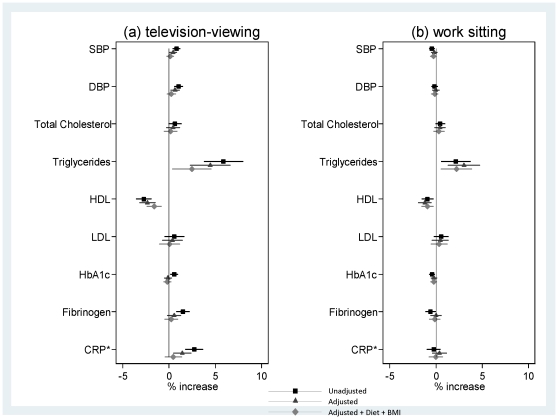
Mean % change (95% CI) in biomarker level, for men, per category increase in television-viewing (a) and sitting at work (b).Footnote: SBP = systolic blood pressure; DBP = diastolic blood pressure; HDL = high-density lipoprotein; LDL = low-density lipoprotein; HbA1c = glycated haemoglobin; CRP = C-reactive protein. *Quarter % change in CRP level per category increase in sedentary behaviour. Corresponding values for a % change in CRP per category increase in (a) television-viewing: 10.88% (95% CI: 7.2%, 14.57%), 5.73% (1.99%, 9.47%) and 1.83% (−1.72%, 5.37%) and (b) sitting at work: −1.01% (−3.80%, 1.78%), 1.47% (−1.57%, 4.51%) and −0.07% (−2.93%, 2.79%) for unadjusted”, “adjusted” and “adjusted+BMI+Diet” respectively. N varies from 3,861 to 3,024 due to variation in missing data. Model “Adjusted” includes: moderate-vigorous leisure activity frequency, smoking, social class at birth and in adulthood, education level, birth-weight and longstanding illness limiting daily activity; for total, HDL and LDL-cholesterol, triglycerides, HbA1c,fibrinogen and CRP additional adjustment for hypertension; for SBP, DBP, HbA1c, fibrinogen and CRP additional adjustment for total and HDL-cholesterol. Model “Adjusted+Diet+BMI” includes: all factors mentioned above plus consumption of chips, sweets/chocolates, alcohol, and BMI.